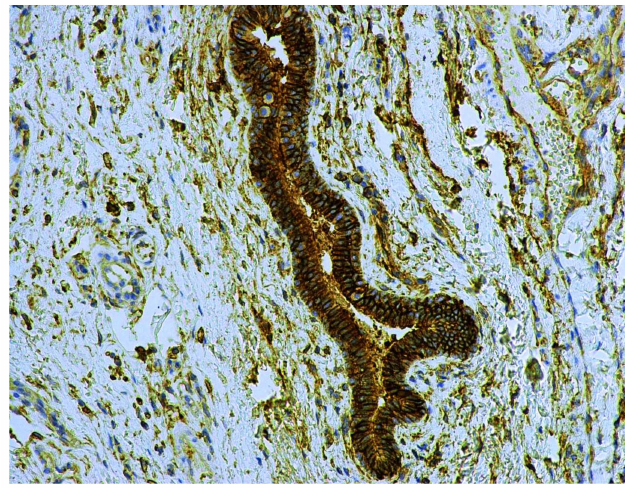
Figure 10. CD9 antigen expression in the lumen microparticiples and the ductal epithelium of small salivary glands under oral leukoplakia. Immunoperoxidase, anti-CD9, original magnification 200 ×